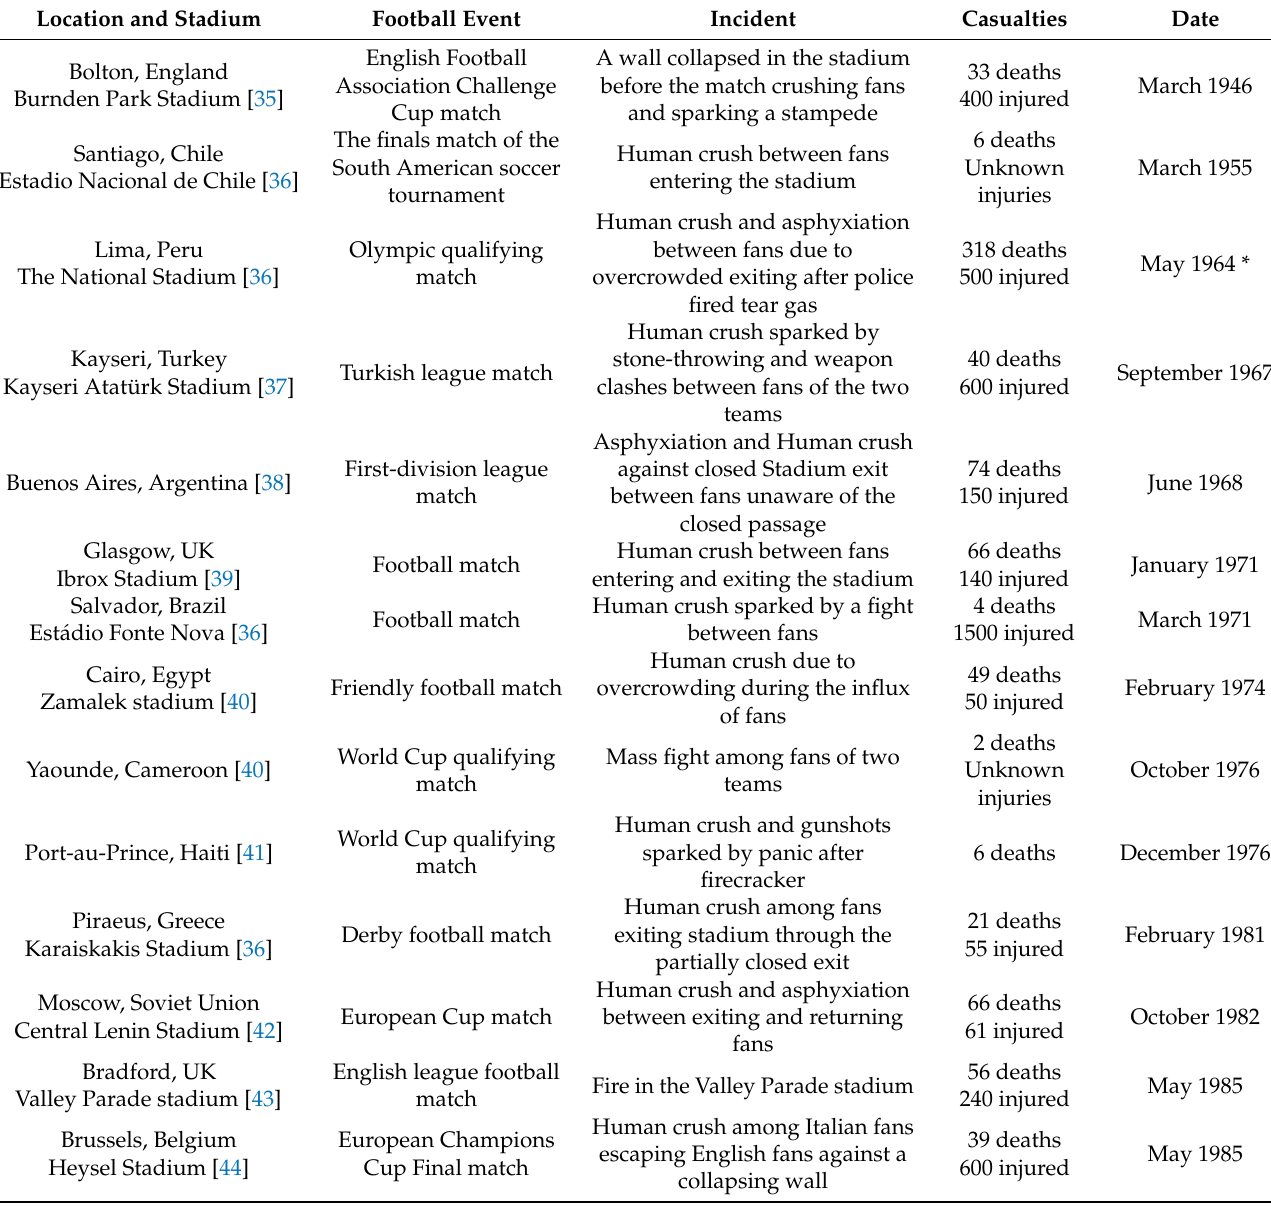
Table 1. Mass gathering event disasters in football matches throughout